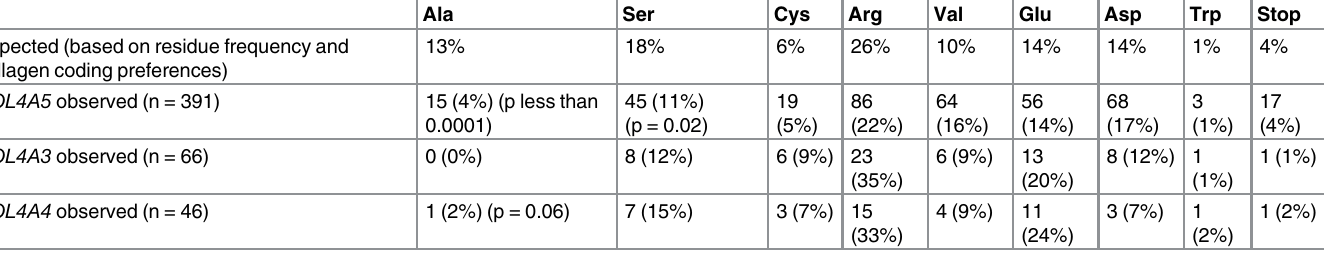
Table 3. Observed versus expected likelihood of Glycine substitutions in the COL4A5 , COL4A3 and COL4A4 genes in Alport syndrome and Thin basement membrane nephropathy. Observed number from the LOVD databases; expected number derived from data for collagen I